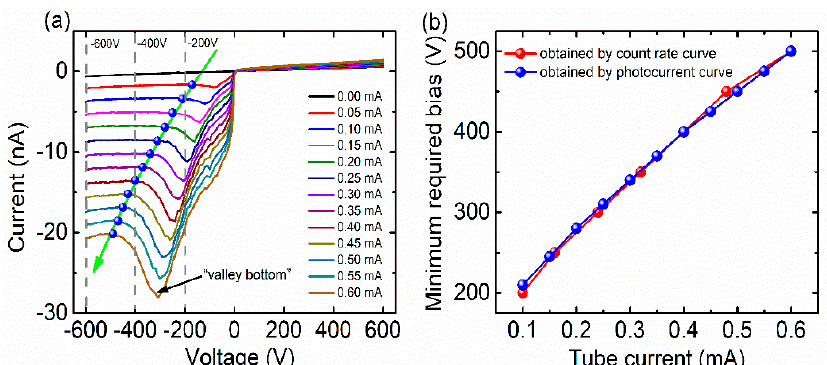
Figure 3. ( a ) I-V curve of a typical pixel at different tube current; ( b ) Minimum required bias voltage data obtained by count rate curve (see Figure 2a) and by X-ray photocurrent curve ( a ). In order to gain understanding of the mechanism of the “valley region”, the X-ray I-t curves were measured at three typical bias voltages ( − 600 V, − 400 V, and − 200 V), as shown in Figure 4.